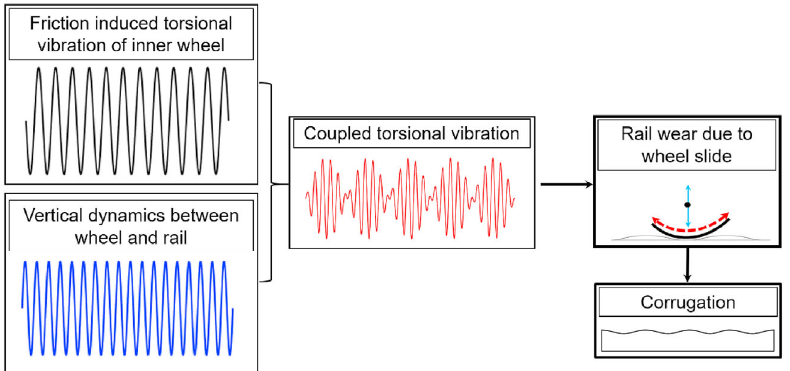
Fig. 27 Full description of dynamic friction and wear of wheel–rail contacts [269]. Reproduced with permission from Ref. [269], © Elsevier B.V., 2021.